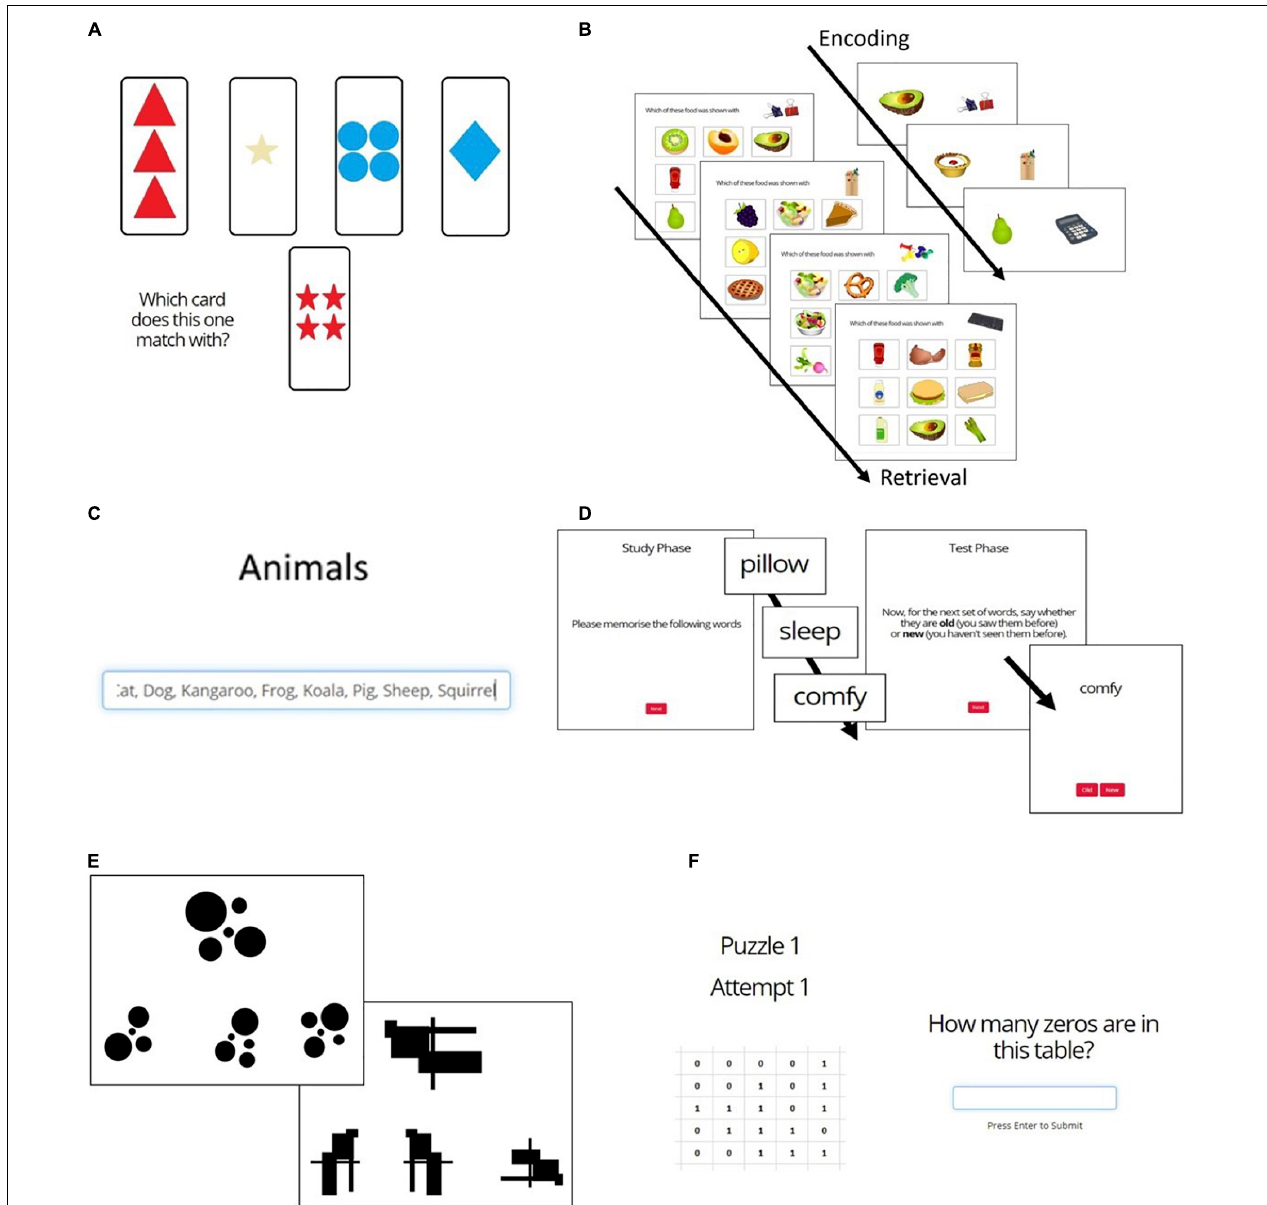
FIGURE 1 | Cognitive tasks. (A) Wisconsin Card Sorting Test; (B) Pictorial Associative Memory Test; (C) Category Fluency Test; (D) Word List Recognition Memory Test; (E) 2D Mental Rotation Test; (F) Number Counting Test (Attention/Bot